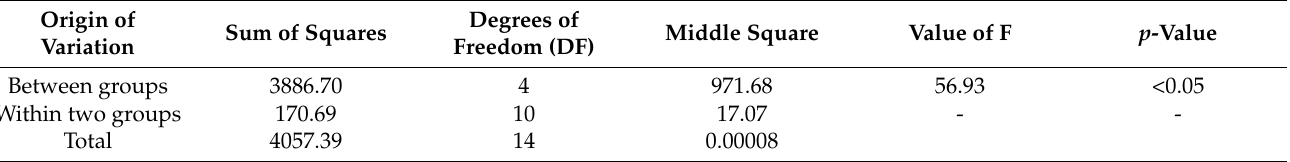
Table 6. Results of variance analysis (ANOVA) performed to evaluate the effect of hydrophilicity on the surface of membranes with copaiba oil content on the chitosan matrix.